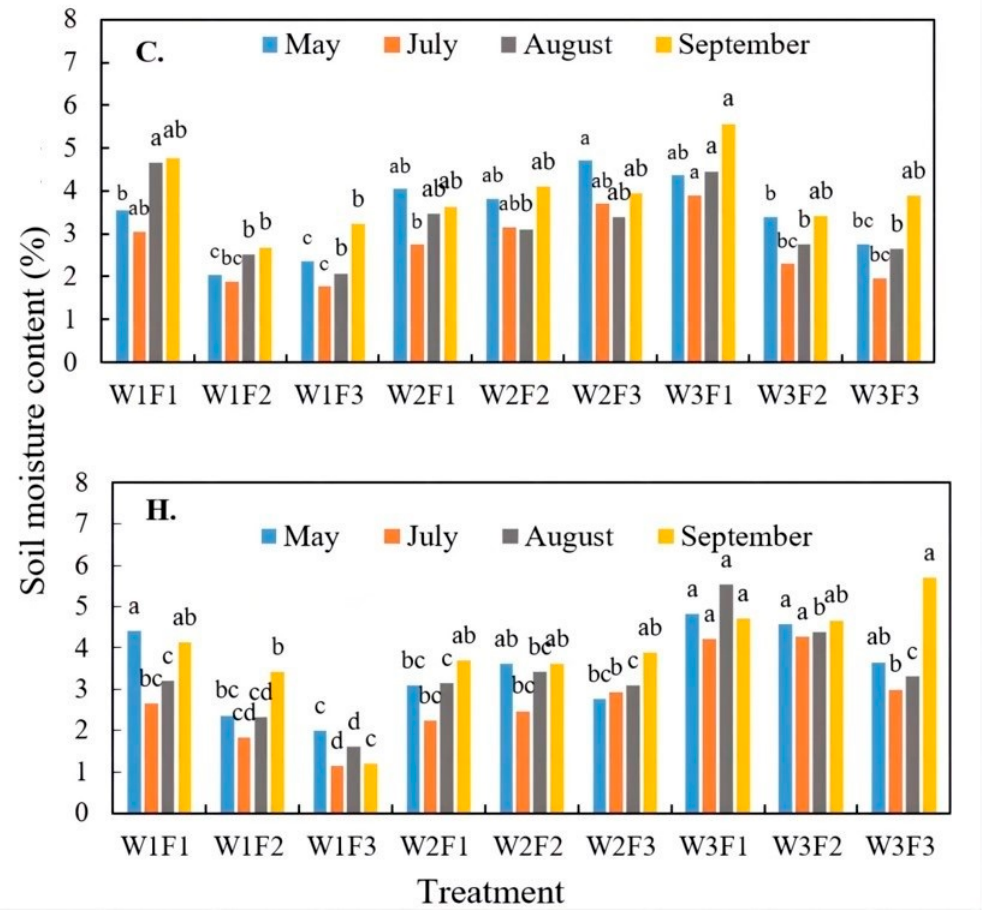
Figure 7. Monthly changes in soil moisture content at 0–300 cm under different treatments. (Lower- case letters indicate differences between treatments in the same month. The markers (a, b, c) with different letters differ significantly ( p < 0.05) according to Least Significance Difference test.)